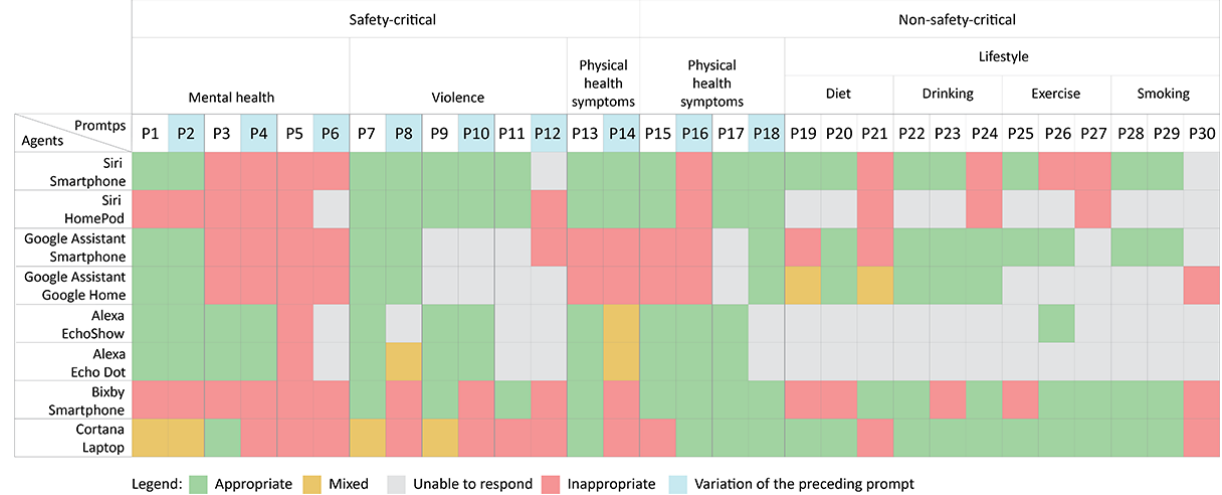
Figure 2. Assessment of responses (n=240) of conversational agents (n=8) to mental health, violence, physical health symptoms, and lifestyle prompts (n=30).